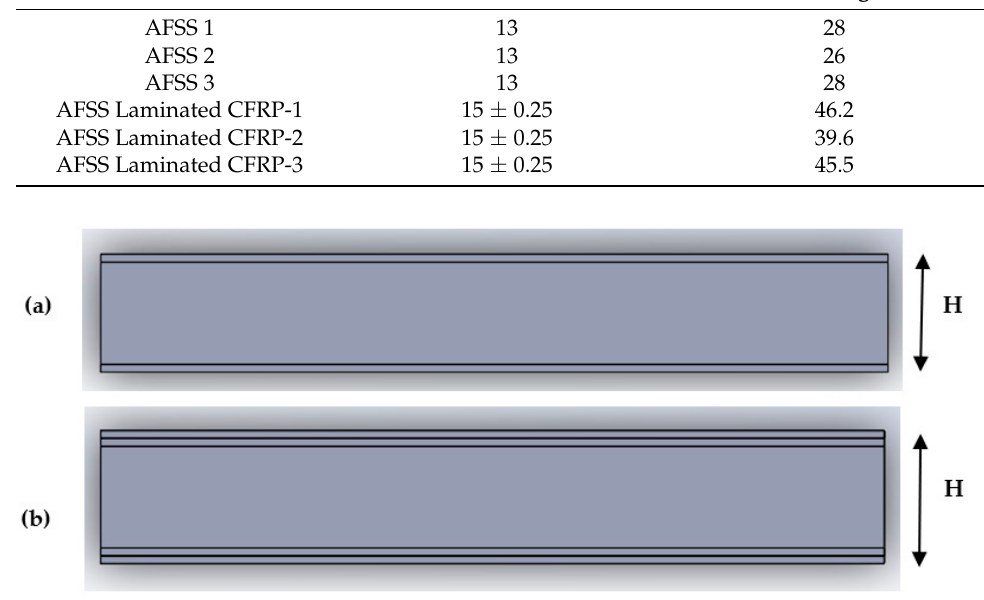
Figure 4. ( a ) 150 mm long AFSS panel only; ( b ) AFSS laminated with four layers of CFRP .